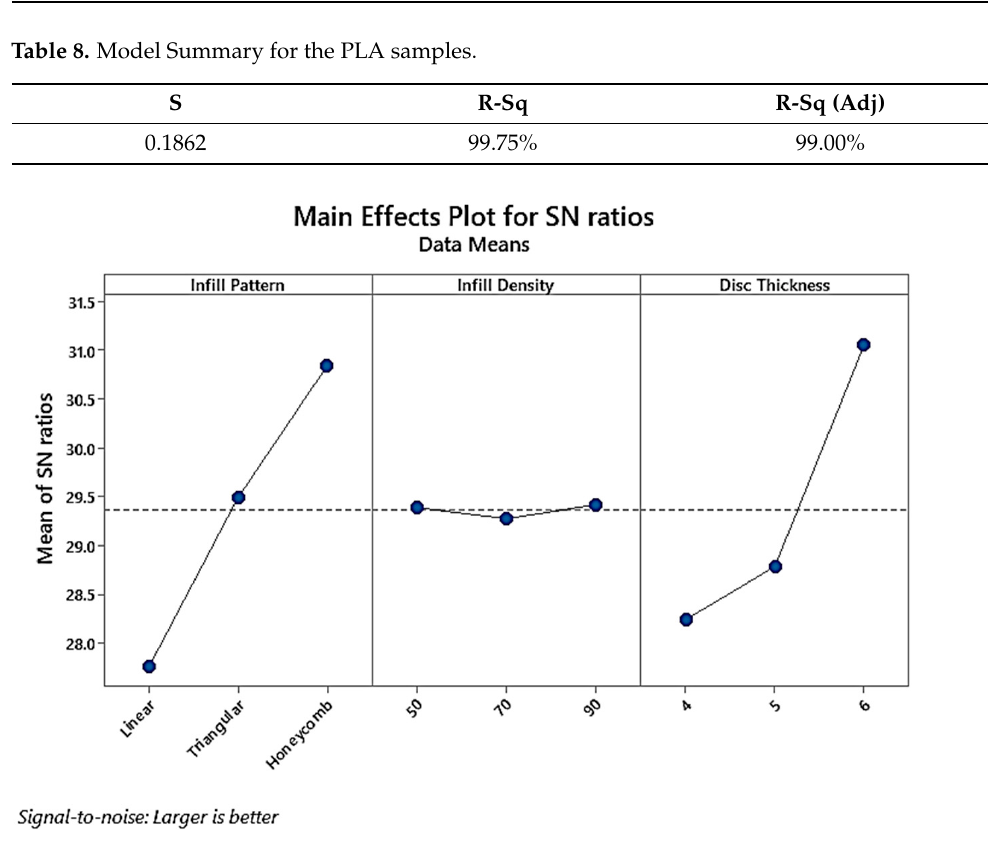
Figure 6. Main effect plot for SN ratios of PLA samples tested for compressive strength.